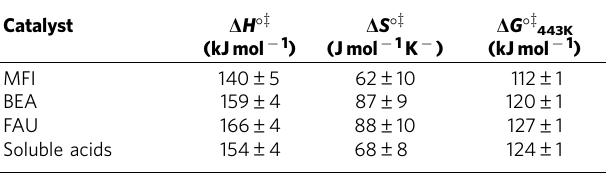
*Standard enthalpies, entropies and free energies of activation (at 443K) on zeolites and homogeneous acids, derived from kinetic measurements and the transition state theory formalism. The error bars for D H (cid:2) z and D S (cid:2) z represent the 1 (cid:4) s s.d.’s, while the error bar for D G (cid:2) z represents the maximum error rounded up to the nearest integer (error analysis protocol detailed in Supplementary Methods).